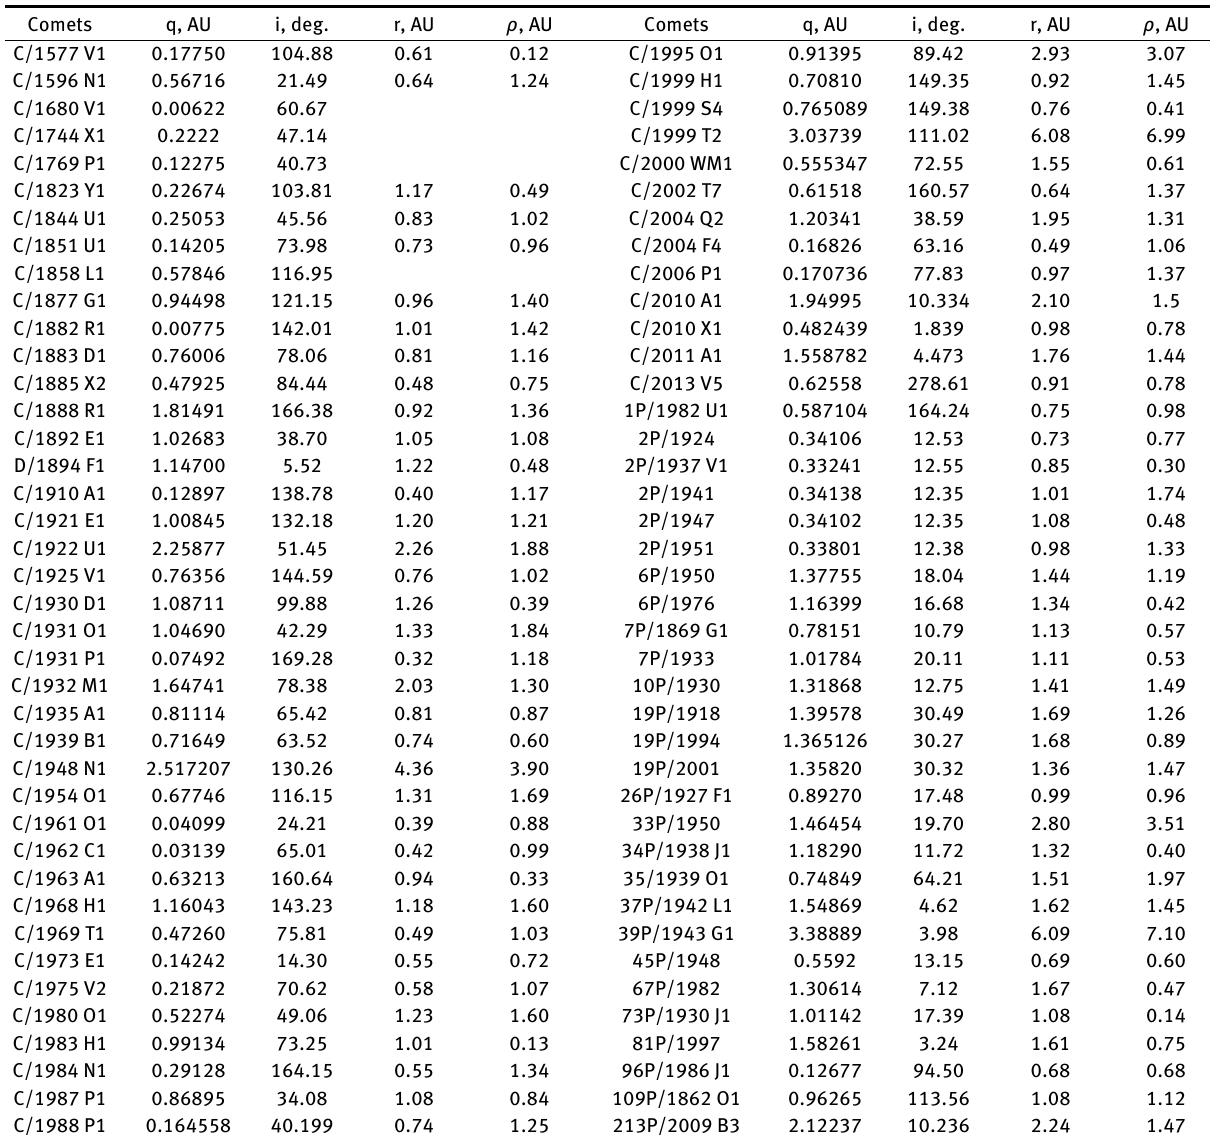
Table 2. The comets with an anomalous tail. Comets q, AU i, deg. r, AU ρ , AU Comets q, AU i, deg. r, AU ρ ,